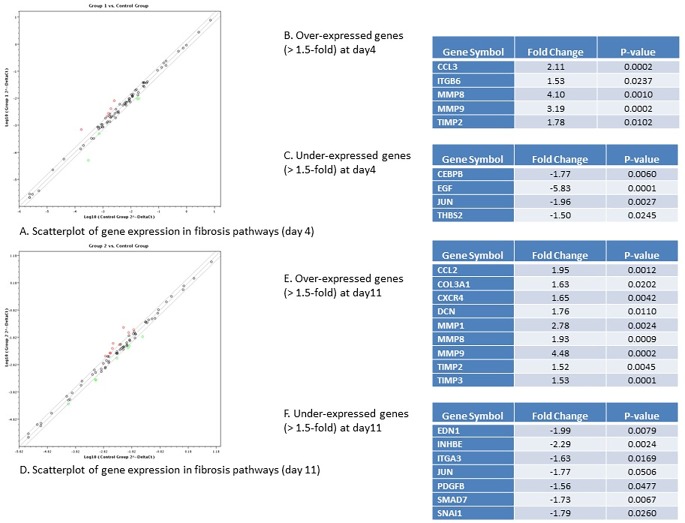
Key genes in fibrosis pathways differentially expressed in liver organoids with miR-122 inhibition vs control organoids.A. Scatterplot of gene expression in fibrosis pathway in miR-122 inhibited organoids after 4 days (group 1) vs control organoids infected with control lentivirus after 4 days (control group). Over-expressed genes are depicted in red while under-expressed genes depicted in green. B. Over-expressed genes (>1.5 fold) at day 4 post-infection. C. Under-expressed genes (<1.5 fold) at day 4 post-infection. D. Scatterplot of gene expression in fibrosis pathway in miR-122 inhibited organoids after 11 days (group 2) vs control organoids infected with control lentivirus after 11 days (control group). Over-expressed genes are depicted in red while under-expressed genes depicted in green. B. Over-expressed genes (>1.5 fold) at day 11 post-infection. C. Under-expressed genes (<1.5 fold) at day 11 post-infection.